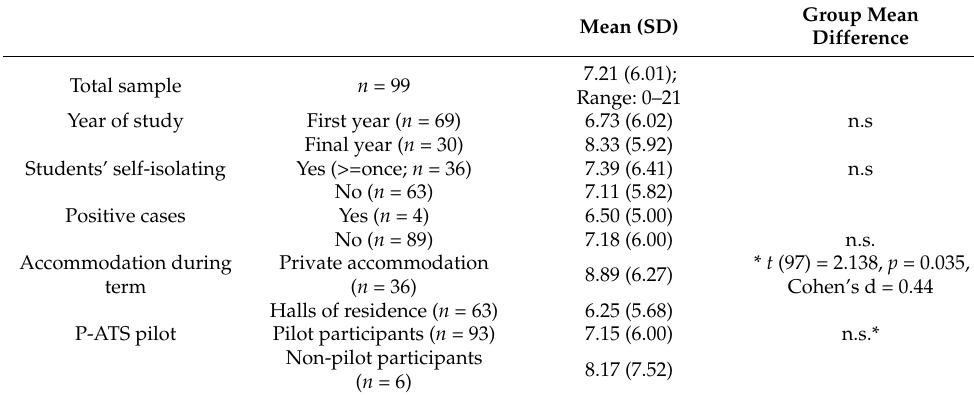
Table 3. Anxiety in study sample ( n =